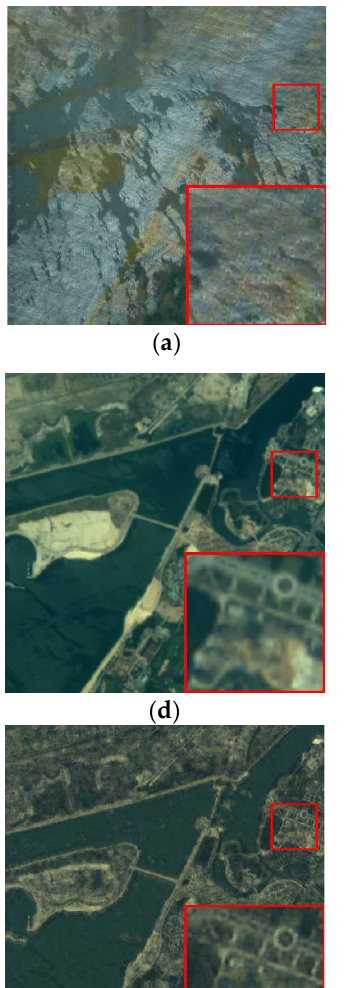
Figure 12. Fused images of QuickBird where ( a ) IHS, ( b ) Wavelet, ( c ) HPF, ( d ) PRACS, ( e ) PNN, ( f ) Fusion-Net, ( g ) SSConv, ( h ) DS-MDNP, and ( i ) Bicubic.